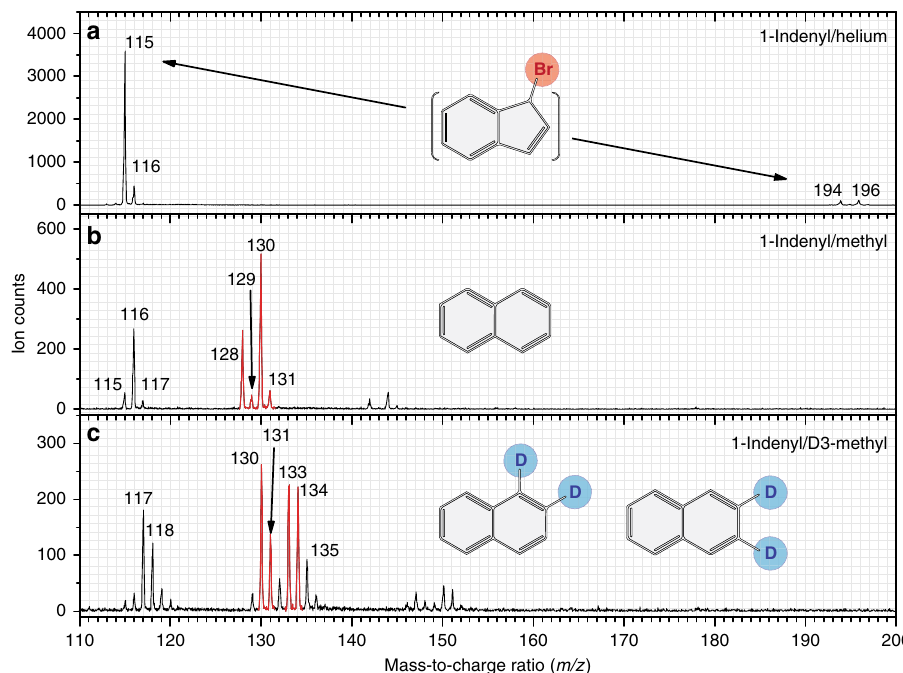
Fig. 2 Mass spectra recorded at a photon energy of 9.50 eV and reactor temperature of 1425 ± 10 K. a 1-indenyl/helium, b 1-indenyl/ methyl, c 1-indenyl/ D3-methyl. The complete assignments of the ion peaks are presented in the Supplementary Information (Supplementary Figs. 6 – 9). The mass peaks identifying (partially deuterated) naphthalenes are marked in red. Source data are provided as a Source Data fi